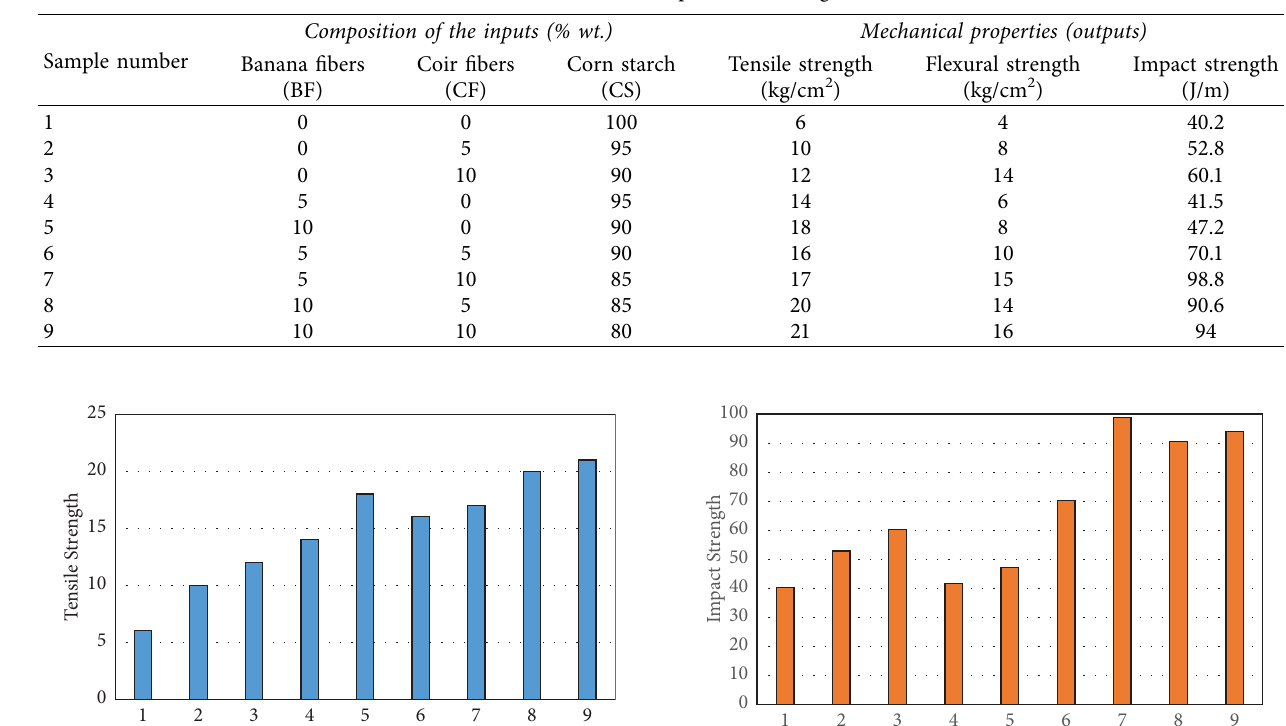
Table 3: Results of experimental design.